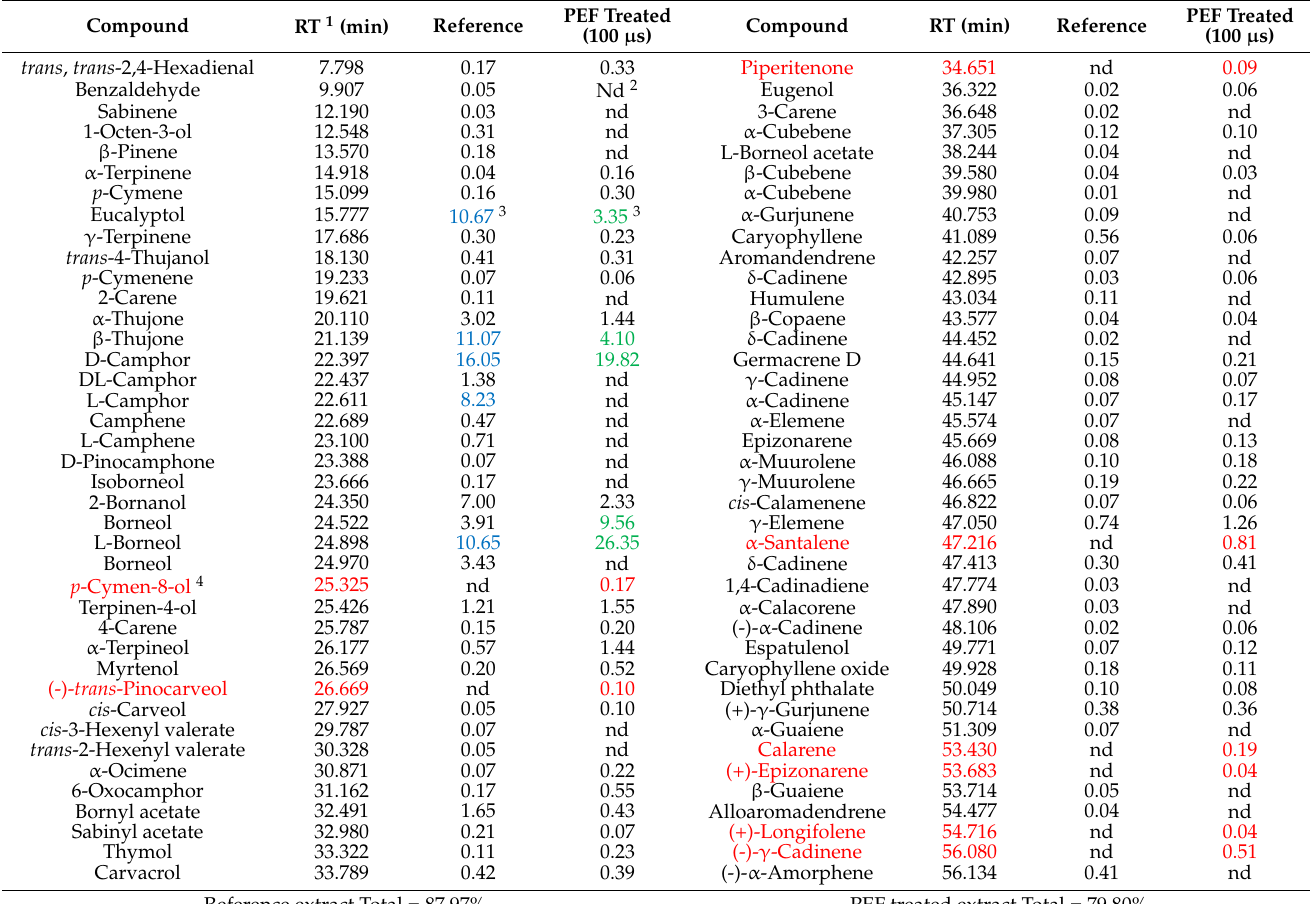
Table 2. Percentage of volatile compounds determined in Salvia officinalis L. extracts (in 25% EtOH) by HS-SPME/GC-MS.